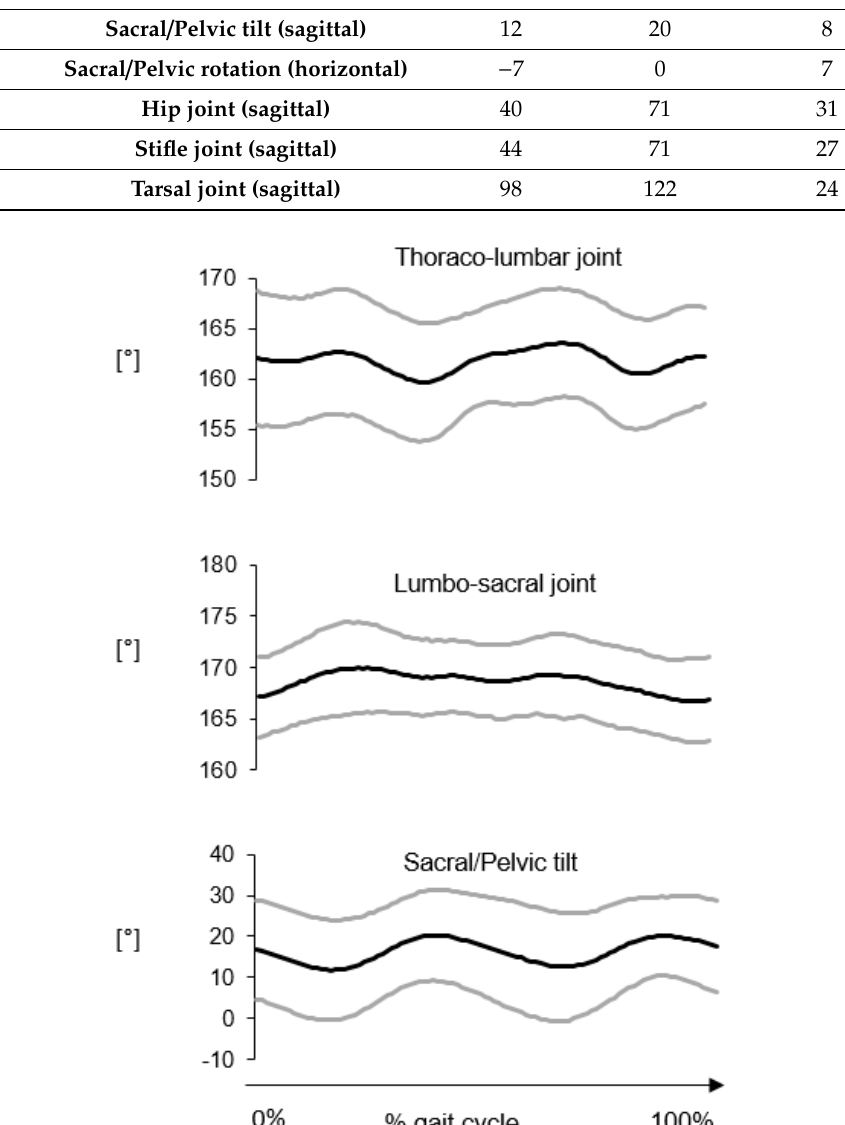
Figure 4. Thoraco-lumbar and lumbar-sacral joint kinematics in the sagittal plane. The average curve (black line) ± the standard deviation (grey lines) were computed over six gait cycles for each subject then averaged for 8 subjects.